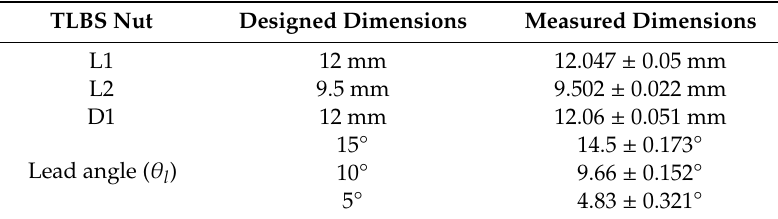
Table 3. Accuracy of manufactured TLBS.